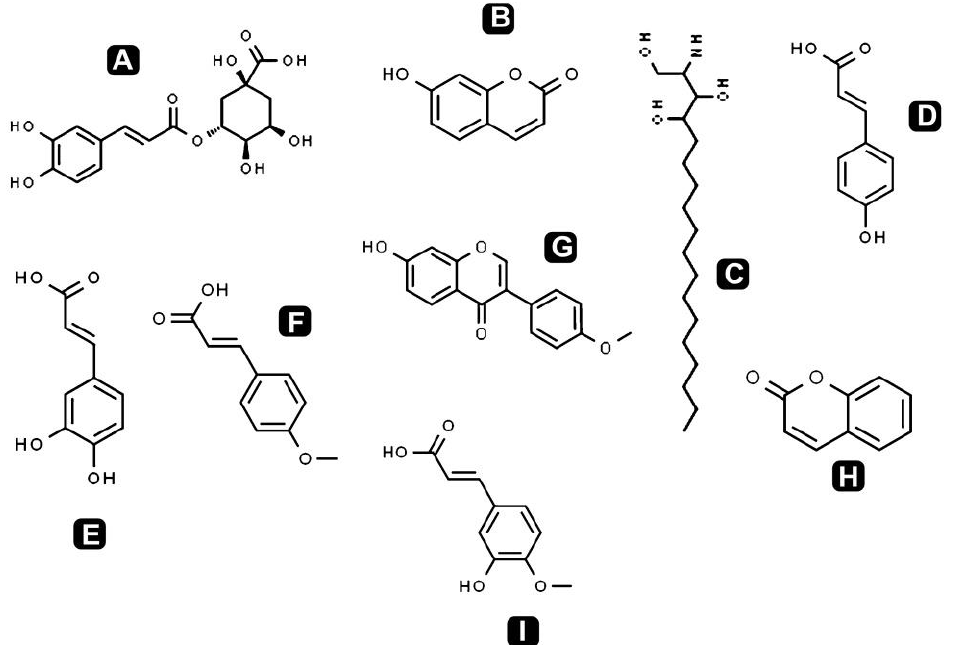
Figure 4. Chemical structures of the identified phenol compounds in S. repanda crude extract. A. Chlorogenic acid B. 7-Hydroxycoumarine C. 2-amino-1,3,4-octadecanetriol D. 4-coumaric acid E. Caffeic acid F. 4-Methoxycinnamic acid G. Formononetin H. Coumarin I. Isoferulic